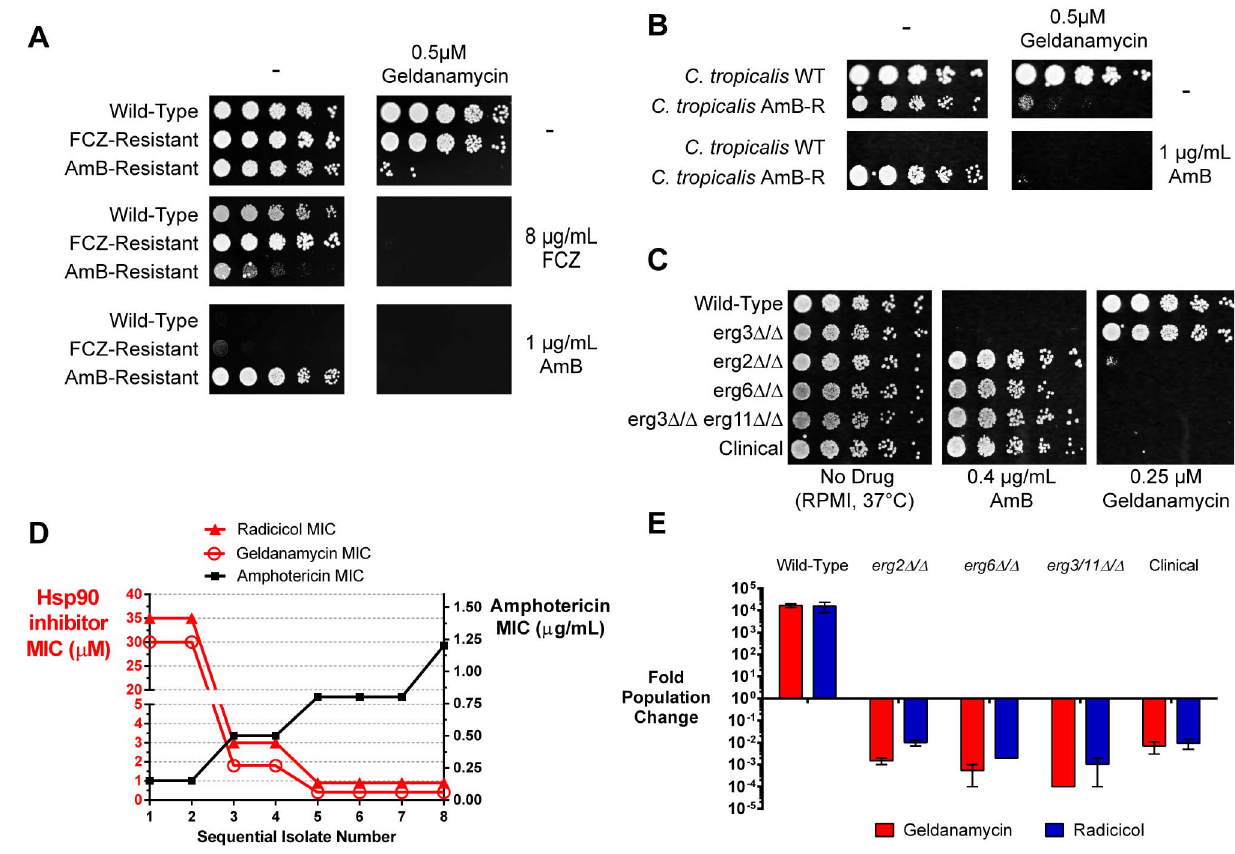
Figure 2. AmB-resistant strains critically depend on high levels of Hsp90 function for survival. (A) Mild inhibition of Hsp90 not only reverses AmB resistance but selectively kills AmB-resistant isolates. Spot assays (5-fold serial dilutions) of wild-type (SC5314), fluconazole-resistant (Isolate # 2, [61]), and AmB-resistant (ATCC 200955) C. albicans on RPMI media containing antifungals and/or Hsp90 inhibitors at the indicated concentrations. (B) Increased dependence on Hsp90 for AmB resistance is conserved in a C. tropicalis clinical isolate. Spot assays of C. tropicalis reference strain MYA-3404 (AmB-sensitive) and ATCC 200956 (AmB-resistant) on media containing AmB, geldanamycin, or both compounds. (C) Isogenic, laboratory-generated AmB-resistant mutants also show an increased dependence on Hsp90. Spot assay of laboratory-generated mutants on AmB and geldanamycin. Fluconazole-resistant erg3 mutant and AmB-resistant clinical isolate are provided for reference. Full MIC data in liquid culture for all strains are provided in Figure S4. (D) In vitro selection for AmB resistance leads to hypersensitivity to Hsp90 inhibition. 24-hour MIC80 (drug concentration reducing growth by 80 percent) of geldanamycin, radicicol, and AmB for each isolate from in vitro evolution series, tested in YPD at 30 u C. Note the discontinuity in the left y -axis due to the dramatic decrease in Hsp90 inhibitor MIC. (E) Hsp90 inhibition is cidal to AmB-resistant strains. Viability assays of wild-type and AmB-resistant C. albicans strains in the presence of the Hsp90 inhibitors geldanamycin or radicicol. Strains were incubated in liquid culture for 24 h with the drugs and then plated for surviving colony-forming units. Drugs were used at 5 m M in all strains. Error bars indicate SEM; each measurement was performed in duplicate. (Figure 2D). We spotted drug-resistant and control isolates on media containing no drug, fluconazole, or AmB, in either the presence or in the absence of the Hsp90 inhibitors.